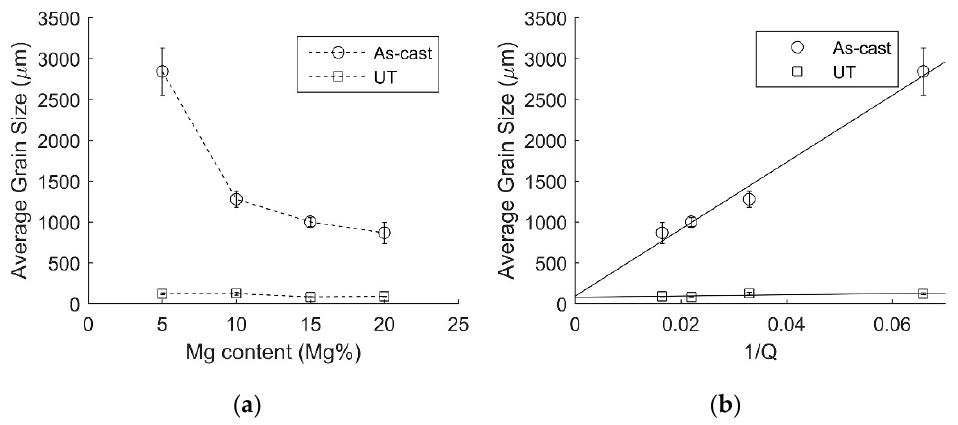
Figure 5. Plots of the average grain size ( a ) versus Mg content and ( b ) versus the inverse of Q.